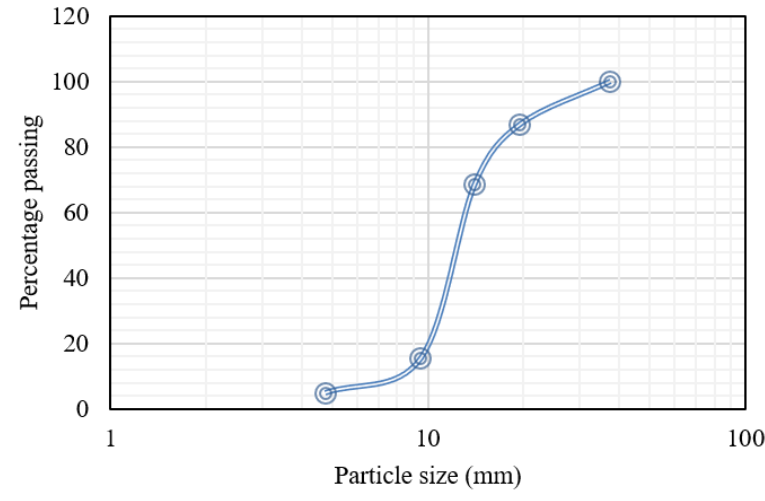
Figure 1. Grading curve of coarse aggregate (CA).